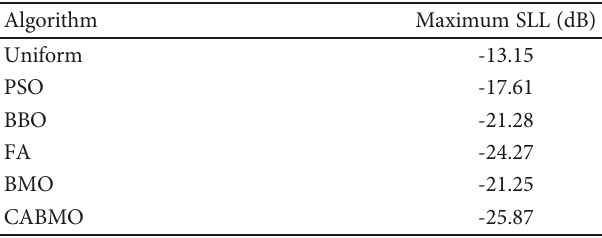
Table 5: The maximum SLL of the 16-element LAA for case two.